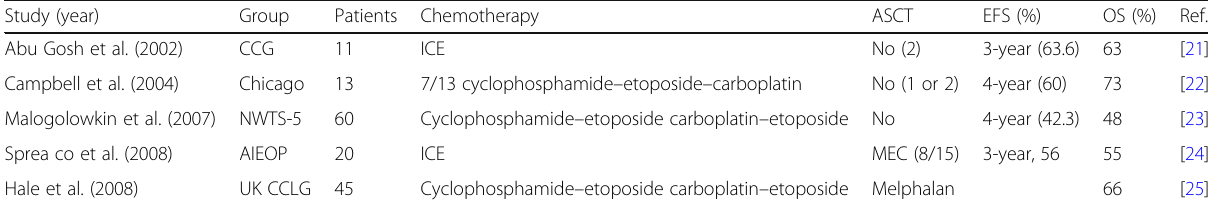
Table 4 Recurrent Wilms ’ tumor: clinical evidence and studies